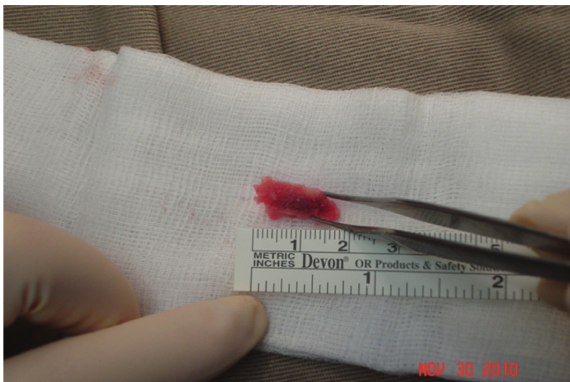
Figure 6: Partly calcified bony tissue up to 18mm × 10mm × 8mm. The microscopic section shows a nubbin of bone surrounded by fibrovascular connective tissue. The marrow is predominantly fatty with prominent ectatic vessels and a patchy mild lymphocytic infiltrate. The decalcification block all